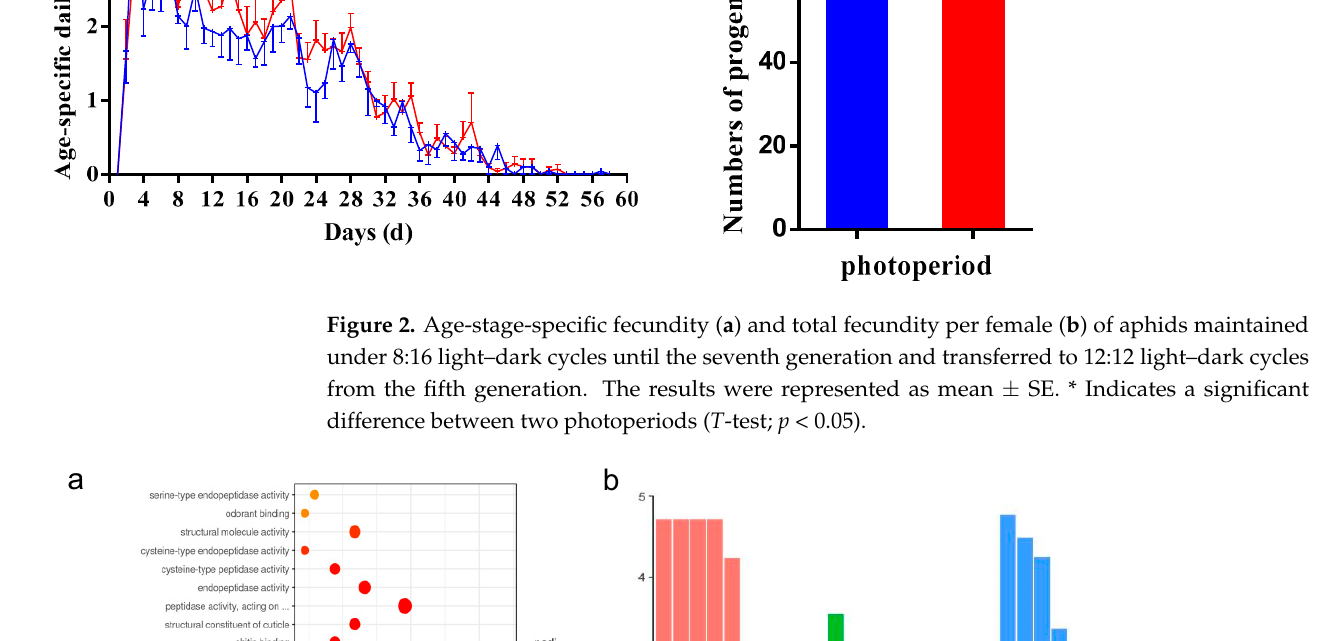
Table 1. Quality control result of sequencing data of Aphis gossypii under 8:16 and 12:12 light– dark cycles.